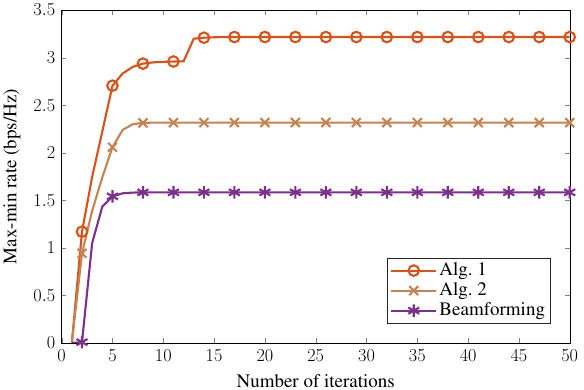
Figure 8. Convergence behaviors of